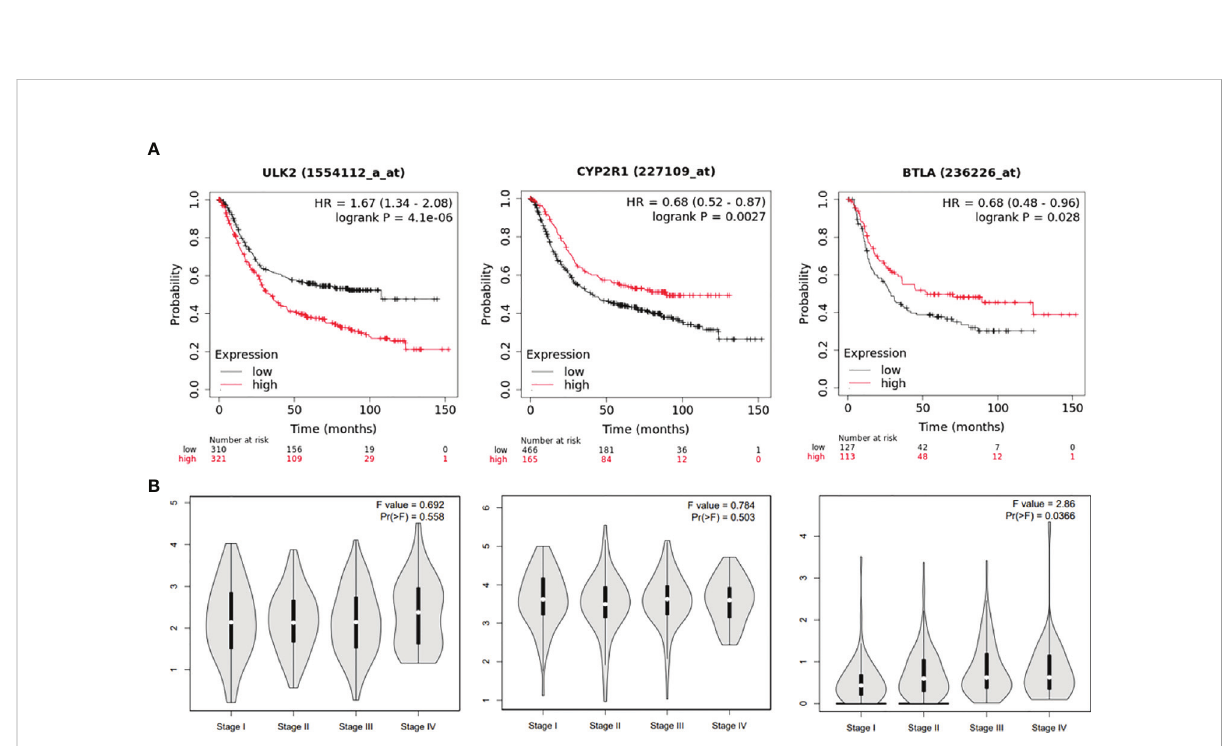
FIGURE 6 ceRNA network hub genes ULK2, CYP2R1, and BTLA are prognostic in TCGA GC cohort. (A) The three genes can separate patients with long and short survival time in GC patients. (B) the 3 genes show no signi fi cant difference at different GC stages.